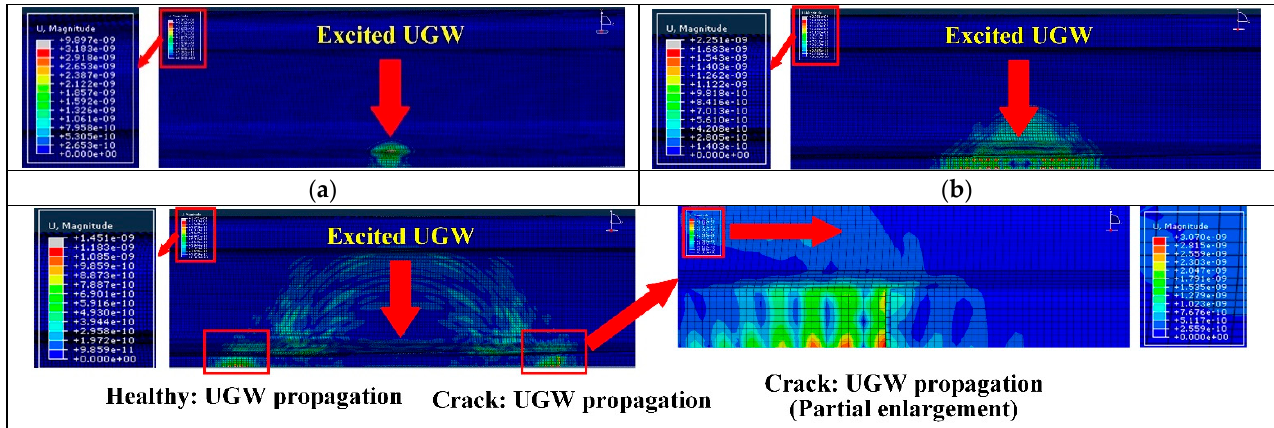
Figure 8. Grid diagram of rail model.